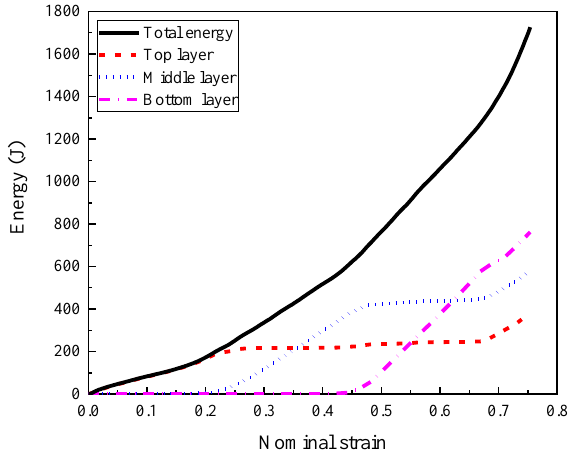
Figure 20. The comparison of energy absorption of layered foam concrete during compression ( t = 0.2:0.2:0.2 and ρ = 408:575:848, 1 m/s).